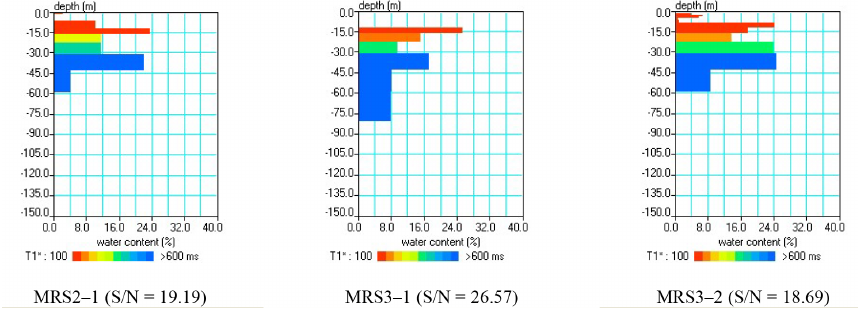
Figure 11. Water content and T 1 of MRS2-1, MRS3-1, and MRS3-2. Table 3. Acquisition parameters of optimal TEM